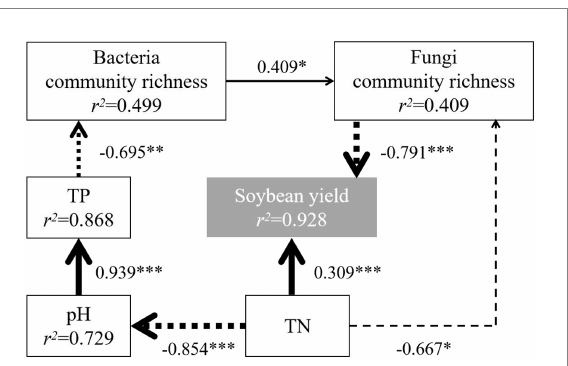
FIGURE 7 Effect analysis of bacterial and fungal communities and chemical indexes on yield. χ 2 /df = 0.662, p > 0.05, goodness-of-fit index >0.90, normed fit index >0.90, comparative fit index >0.90, root square mean errors of approximation <0.05, Akaike information criterion = 39.325, bootstrap = 1,000. The solid line represents positive correlation, the dotted line represents negative correlation, and the wider the line, the stronger the significance. * p < 0.05, ** p < 0.01, and *** p < 0.001. TN, total N; TP, total